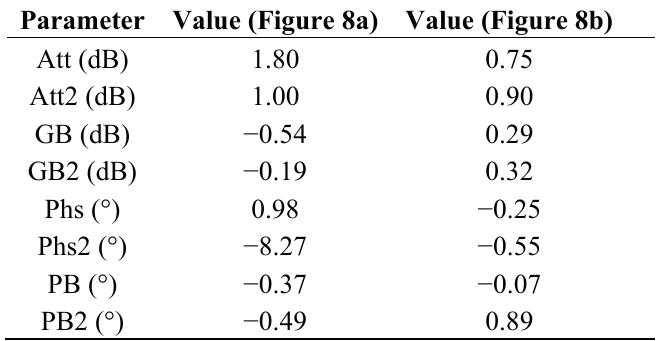
Table 7. Model parameters fitting the measurement results in Figure